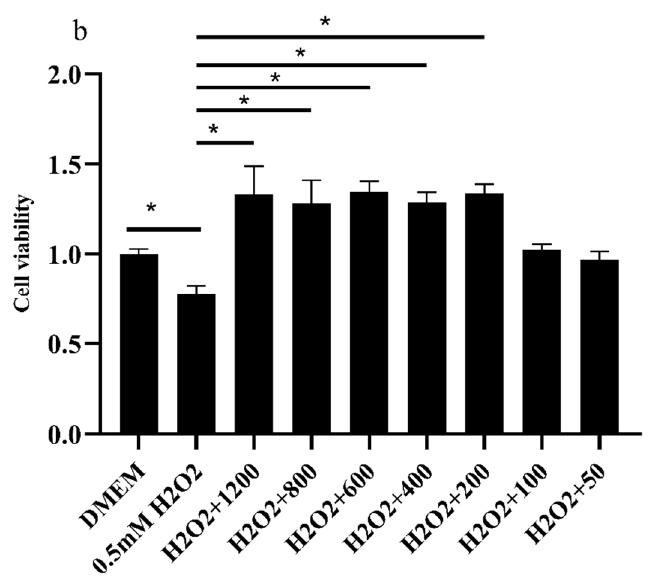
Figure 6. Effect of 3-h pre-treatment with different concentrations (50–1200 µg/mL) of in vitro digested Qu50%–Ch50% on IPEC-J2 cells further stressed with 2% DSS for 24 h ( a ) or 0.5 mM of hydrogen peroxide (H 2 O 2 ) ( b ) on the metabolic activity (expressed as cell viability, MTT assay). Data are expressed as lsmeans ± SEM ( n = 3, one-way ANOVA). * Denote significant differences ( p < 0.05).